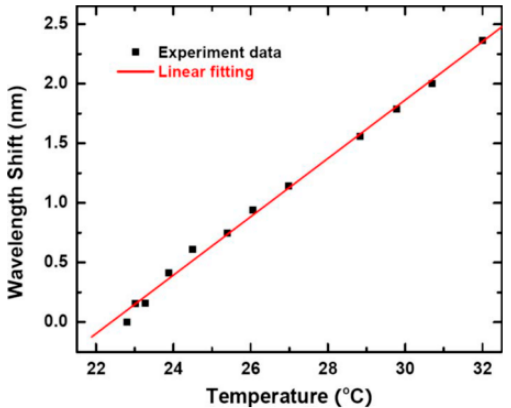
Figure 3. Relationship between temperature and the wavelength shift in the amorphous silicone microsphere resonator. [Reprinted/Adapted] with permission from ref [23], [AIP].